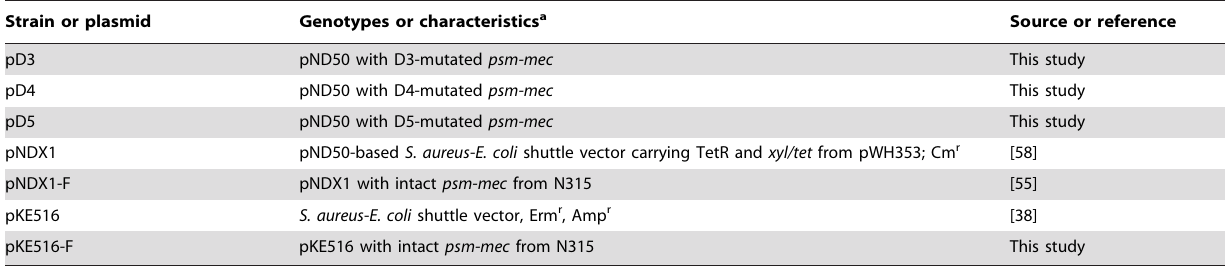
Figure S1 Integration of psm-mec into chromosomes of CA- MRSA strains. ( A ) The genomic region that was integrated with psm-mec is schematically represented as the psm-mec- integrated CA- MRSA strain. Probe DNA regions, construct of targeting plasmid, genomic region of CA-MRSA (type-IV SCC mec ) are presented above. Predicted lengths of DNA fragments that were digested with Sph I are presented. ( B ) Genomic DNAs of MW2, FRP3757, and their psm-mec -integrated mutants were digested with Sph I and subjected to Southern blot analysis using probes 1 and 2. P indicates the parent strain. A, B, and C means independently obtained psm-mec integrated mutants. (TIF) Figure S2 Determination of 3 9 -terminus of psm-mec RNA. The 3 9 -terminus of psm-mec RNA was determined by S1 mapping. S1- digested products and Maxam-Gilbert sequencing ladders were electrophoresed in 8 M urea-7.5% polyacrylamide gel. Lanes 1 and 2 represent products that were digested with 75 U and 450 U of S1 nuclease, respectively. Lanes AG, CT, and C represent Maxam-Gilbert sequencing ladders. The nucleotide sequences of psm-mec RNA and the antisense RNA are presented on the left side of the panel. Black stars represent the 3 9 -terminus of psm-mec RNA determined by the migration of the S1-digested product. (TIF) Figure S3 Effect of the mutated psm-mec sequences found in clinical MRSA isolates on S. aureus Newman strain. ( A ) The amount of PSM-mec in the culture supernatant of the Newman strain transformed with empty vector (pND50), intact psm-mec (pF), D1-mutated psm-mec (pM1), D2-mutated psm-mec (pD2), D3- mutated psm-mec (pD3), D4-mutated psm-mec (pD4), or D5-mutated psm-mec (pD5) was measured. The vertical axis represents the relative amount of PSM-mec against that of Newman transformed with pF. Means 6 standard deviations from four independent experiments are shown. Student t-test P-values between pF- transformed Newman and other strains are presented.